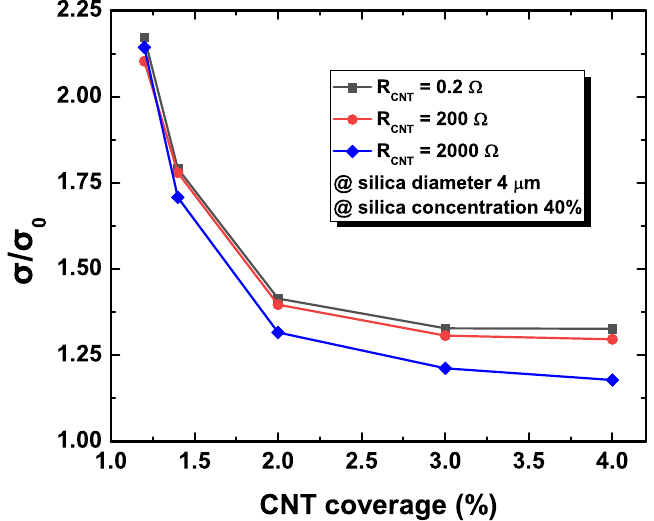
Figure 4. Normalized conductance changes with respect to NW